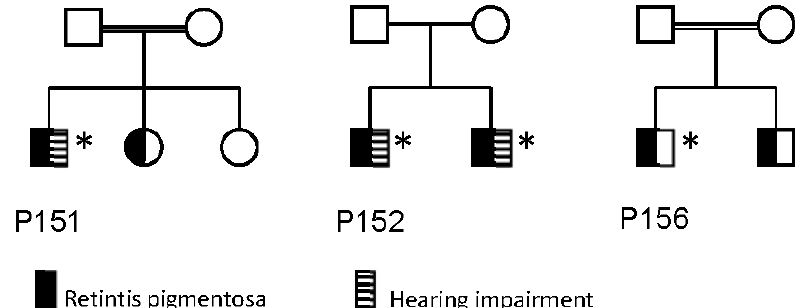
Figure 2. Pedigrees of families of P151, P152 and P156. Individuals marked with an asterix (*) has been genotyped, and has the genotype listed in Table 2.